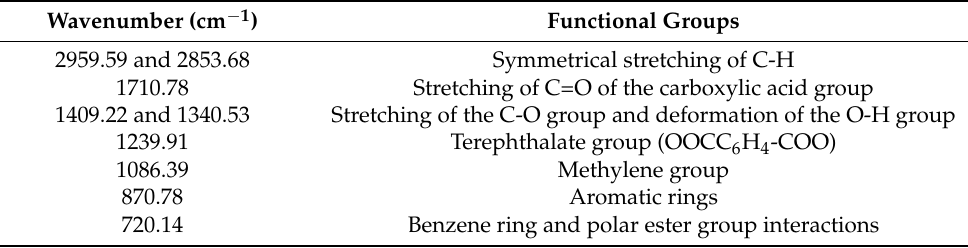
Table 6. Wavenumbers and respective identifiable functional groups for v-PET [24,25].